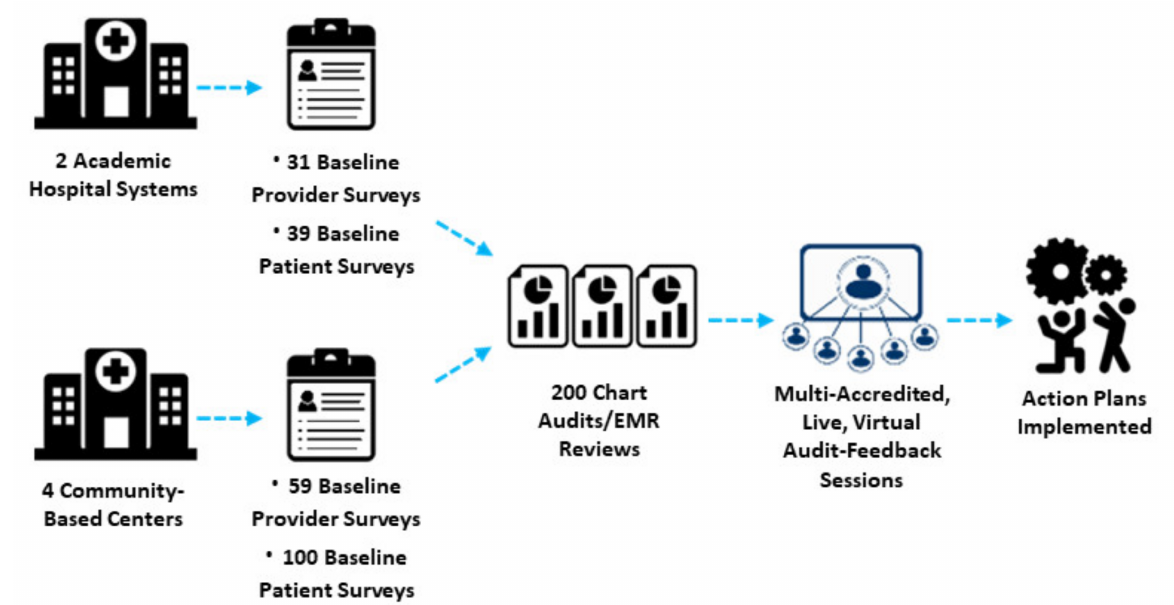
Figure 1. Schematic of Quality Improvement